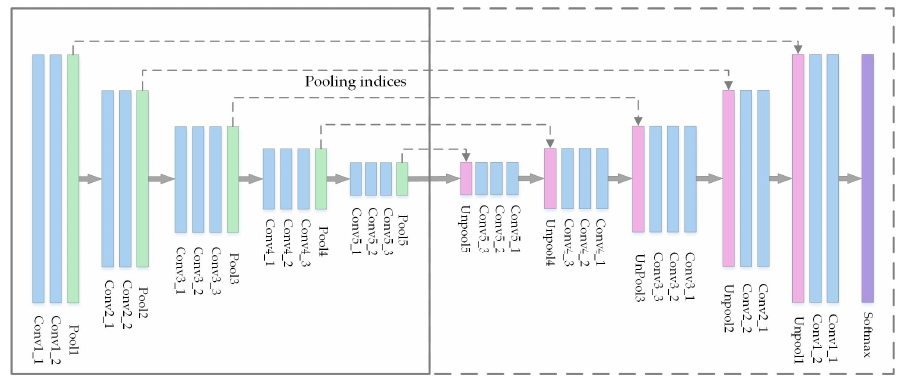
Figure A2. Architecture of SegNet, where structure depicted in the solid-line box is encoder and structure depicted in the dashed-line box is decoder.